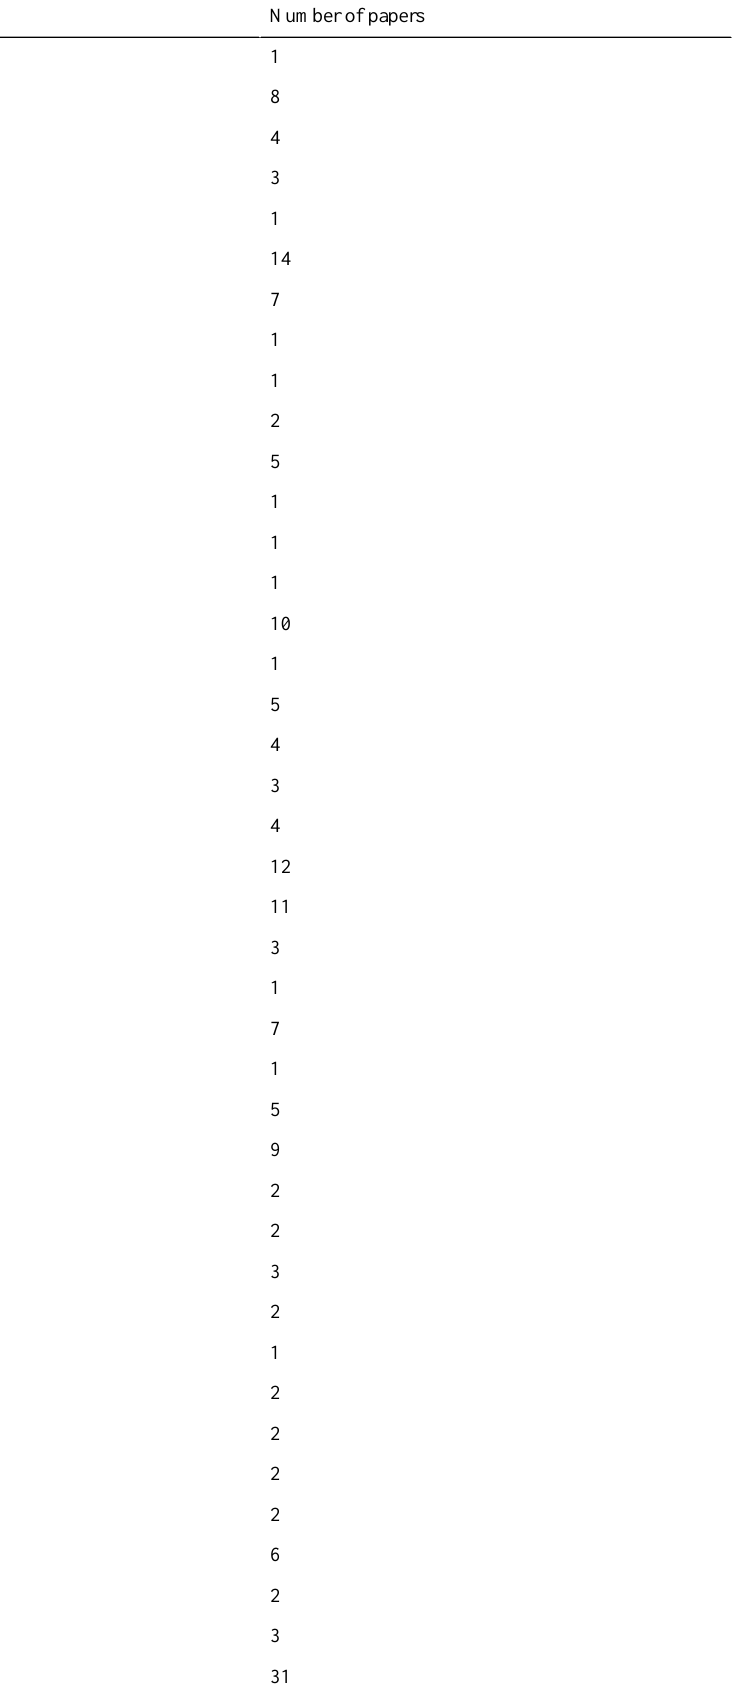
Table 1. Geographical distribution of publications between 2005 and 2012.